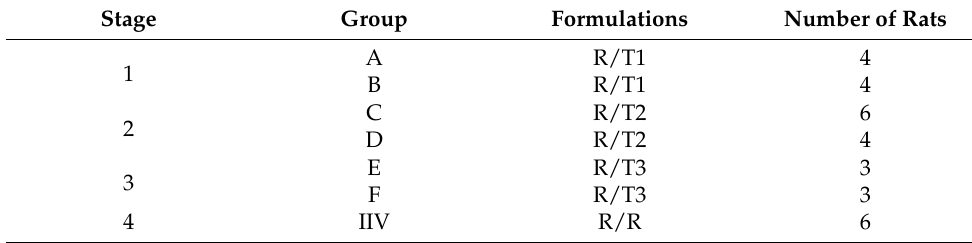
Table 1. Summary of formulations administered to rats and number of rats enrolled into each stage and group. R–reference formulation, T1–T3—innovative formulations. Stage Group Formulations Number of